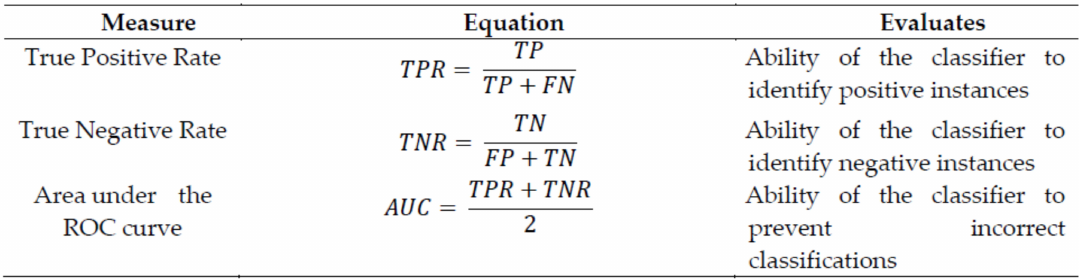
Figure 3. Some performance measures for two class imbalanced